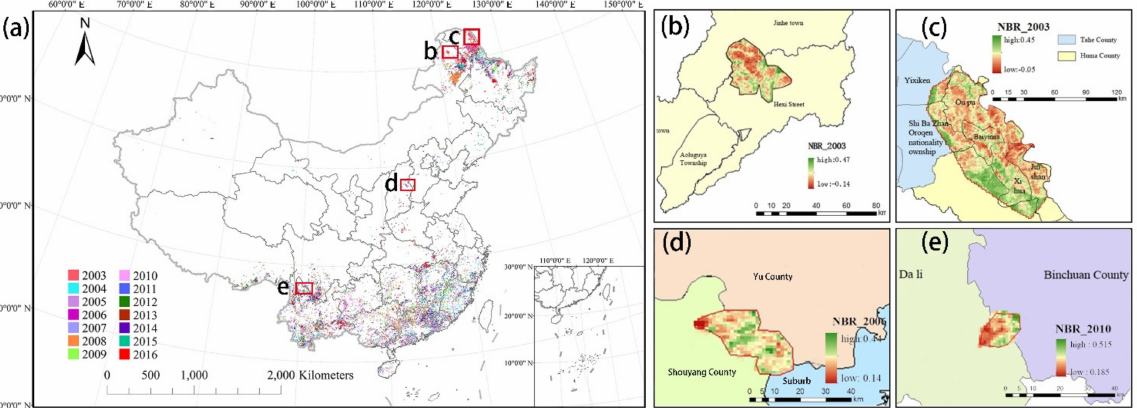
Figure 1. Study area and the Normalized Burn Ratio (NBR) distribution during fire disturbance.